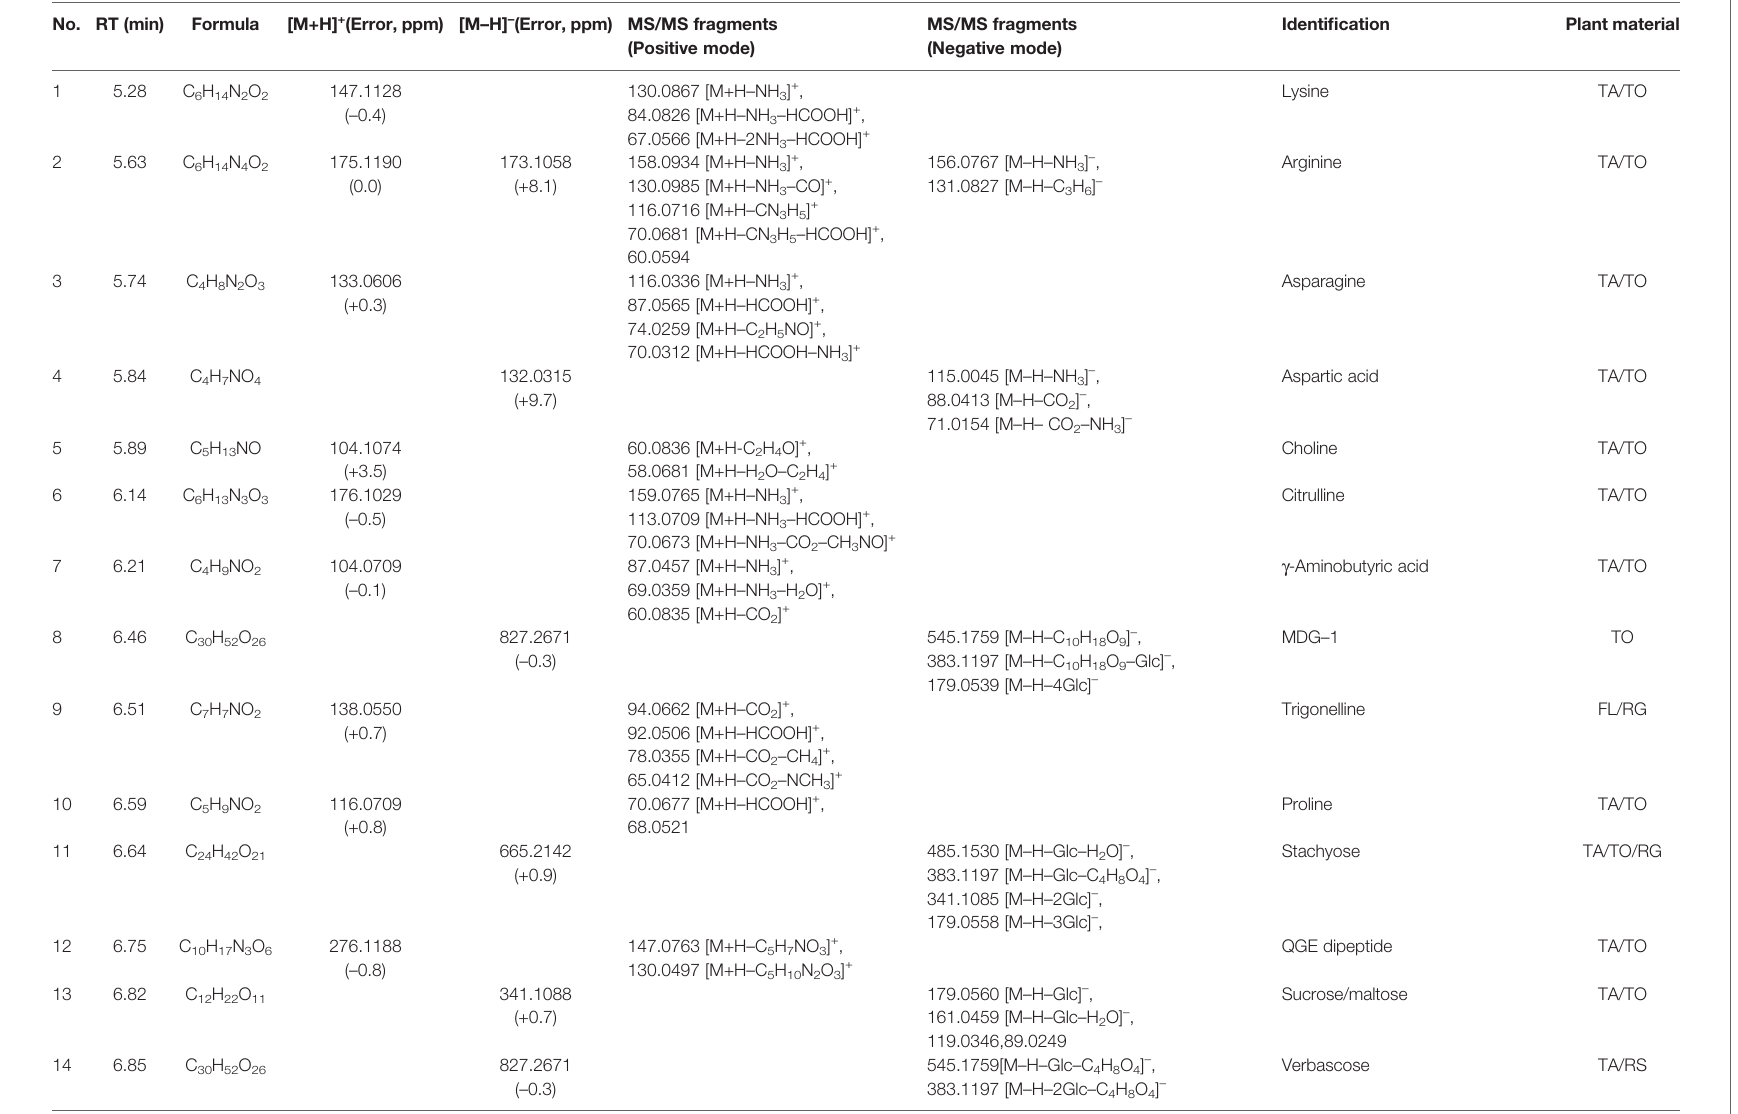
TABLE 1 | Identi fi cation of the chemical composition of Kouyanqing Granule